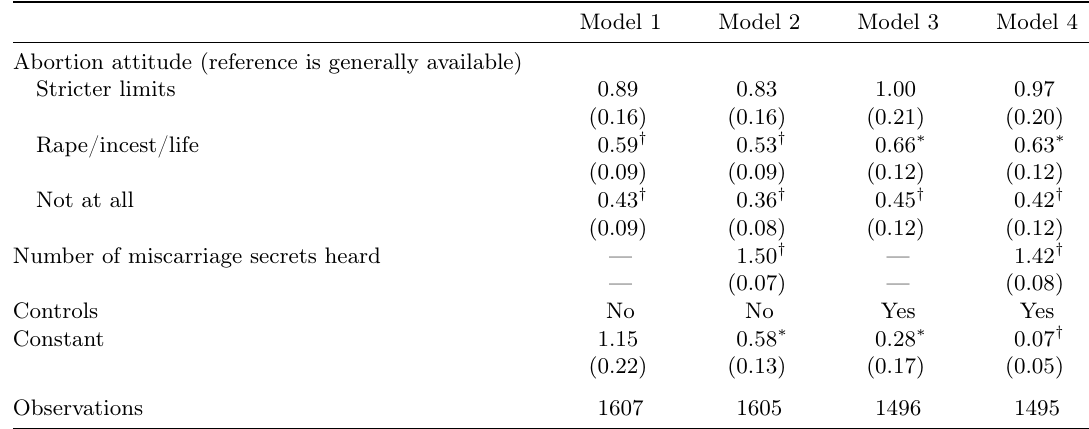
Table 3: Odds Ratio for Reporting Knowing Someone Who Has Had an Abortion, AMACS 2012 Model 1 Model 2